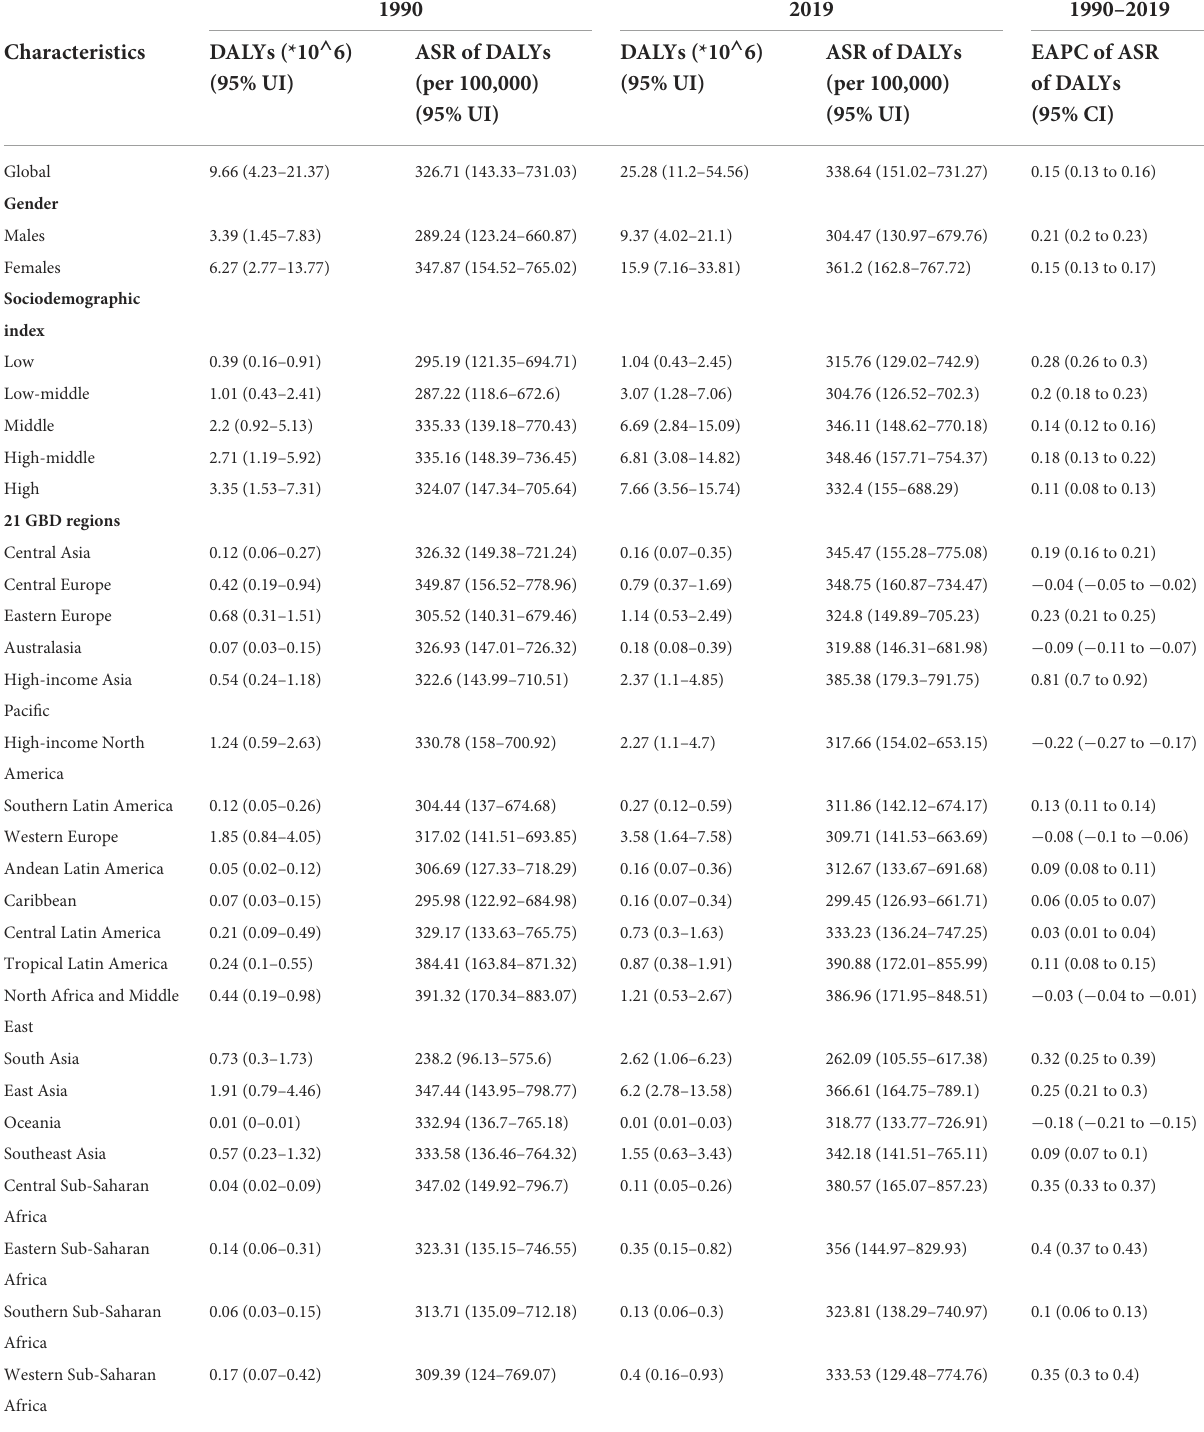
TABLE 4 The DALYs cases and ASR of DALYs of Alzheimer’s disease and other dementias in 1990 and 2019 and its